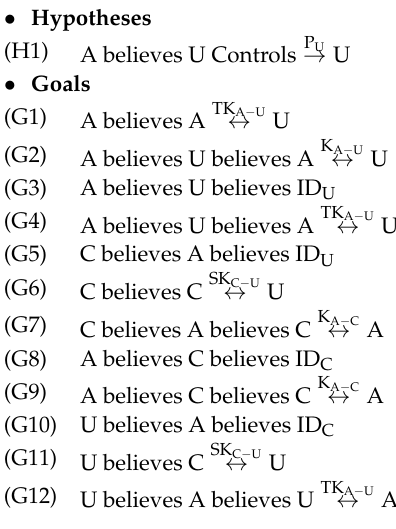
Figure 14. He and Zeadally’s protocol. ( a ) Registration phase. ( b ) Authentication phase.